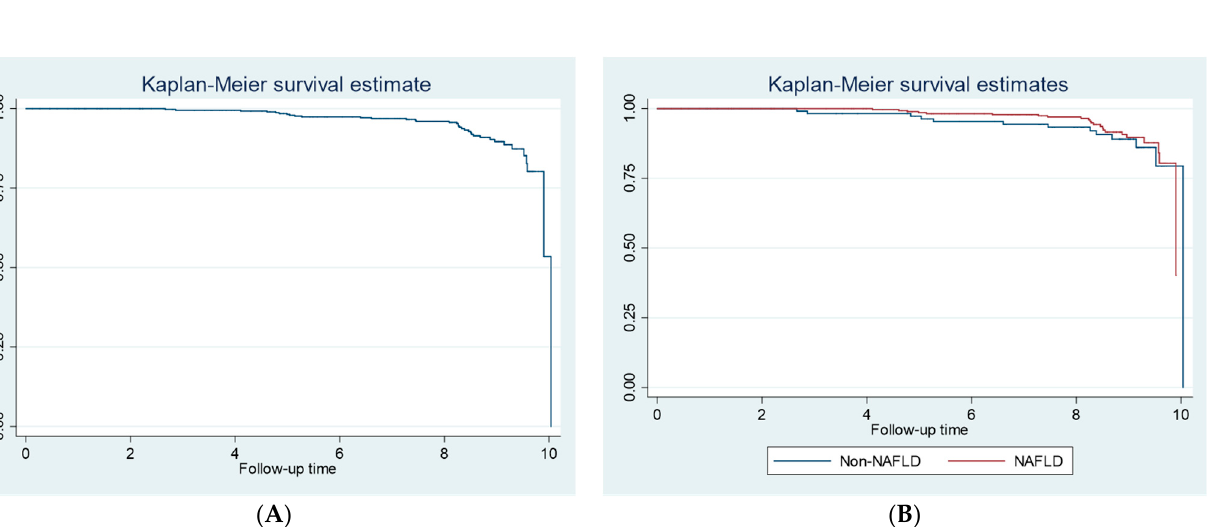
Figure 3. Kaplan–Meier curves of atherosclerotic cardiovascular diseases incidence for ( A ) the whole cohort and ( B ) subgroups of patients with and without nonalcoholic fatty liver disease. The Cox proportional hazards regression model with time-varying covariates demonstrated that only HDL-C level was associated with ASCVD incidence rate, as shown in Table 4. Table 4. Cox proportional hazards regression model with time-varying covariates for atheroscle- rotic cardiovascular disease outcome. Covariates